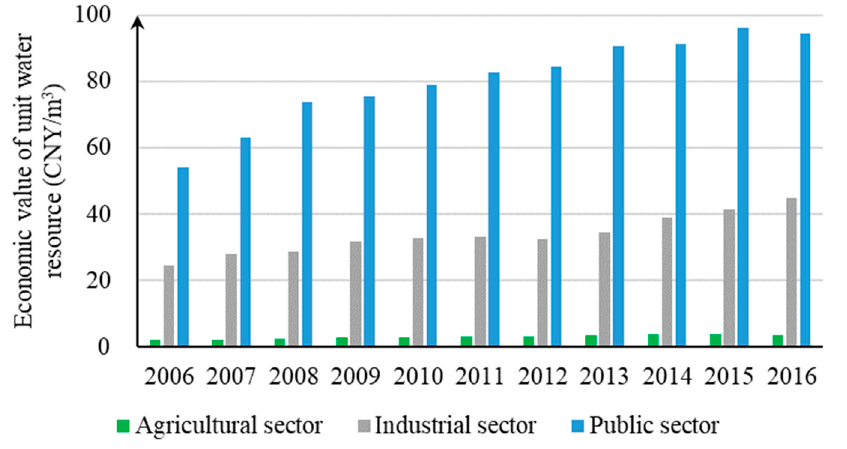
Figure 6. Economic value (marginal value) of unit water resource of agricultural, industrial, and public water use sector.